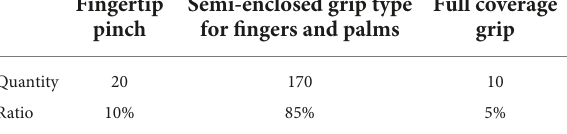
TABLE 2 Statistics for tomato grip types.